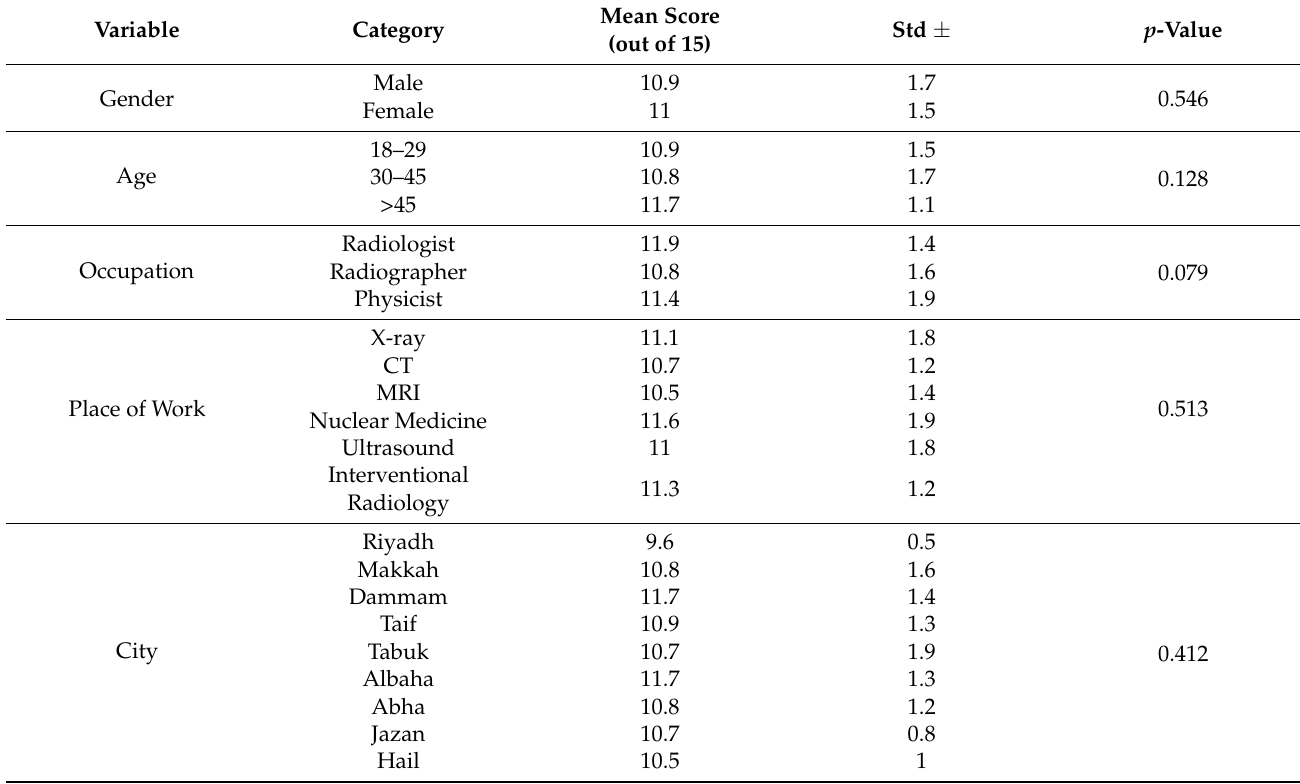
Table 3. The rates of correct answers according to demographic characteristics ( n = 128). The mean difference is significant at the 0.05